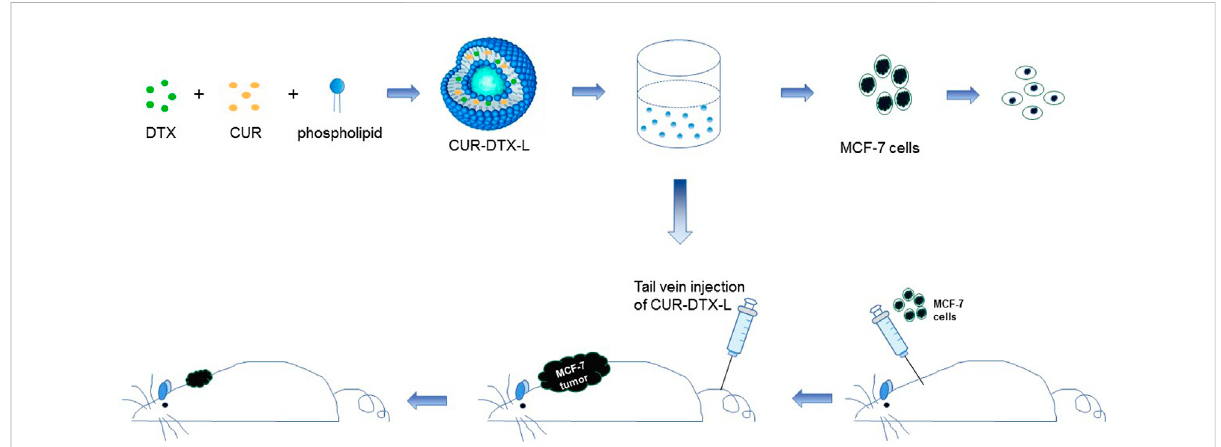
FIGURE 1 Schematicdiagram of the assembly of CUR-DTX-L and its in vitro and in vivo ef fi cacy tests. CUR-DTX-L was prepared by ethanol injection.The in vitro ef fi cacy of CUR-DTX-L was investigated in the MCF-7 cell line, and its in vivo ef fi cacy was investigated with an MCF-7 nude mouse